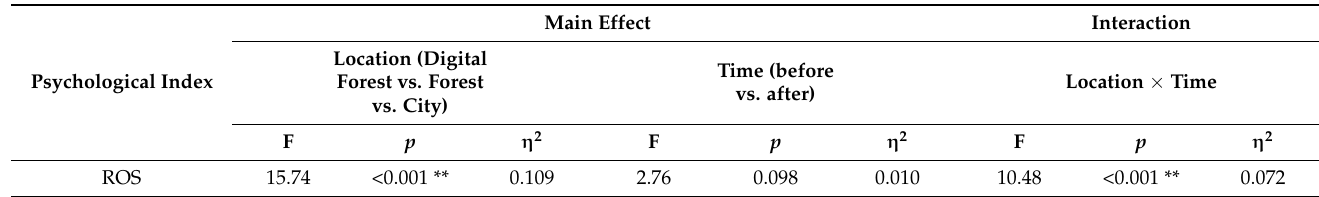
Table 11. Comparative analysis of ROS in three settings (two-way analysis of variance).